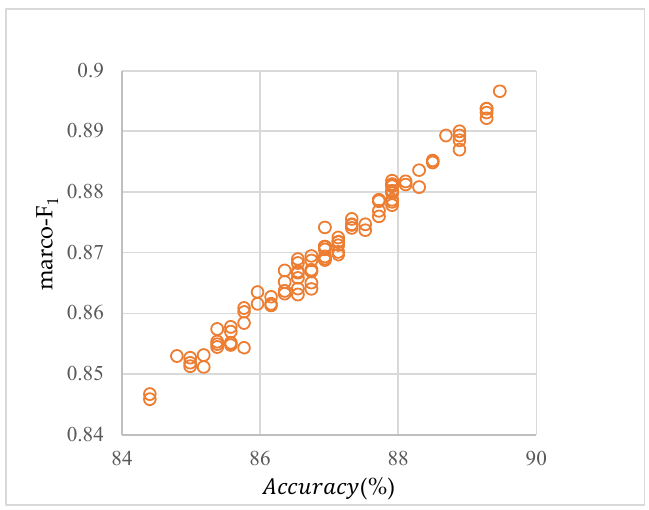
Figure 8. Performance metrics of the Adam-based LFD model on the test